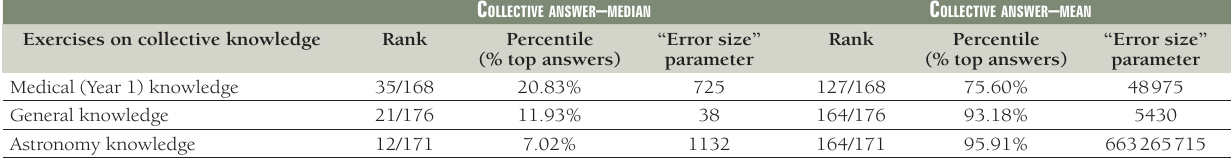
Table 6. The rank and the percentile of the collective answer (based on either median or mean) among all individual answers provided by the students in three consecutive exercises where students had a decreasing level of expert knowledge* C olleCtive answer – median Exercises on collective knowledge